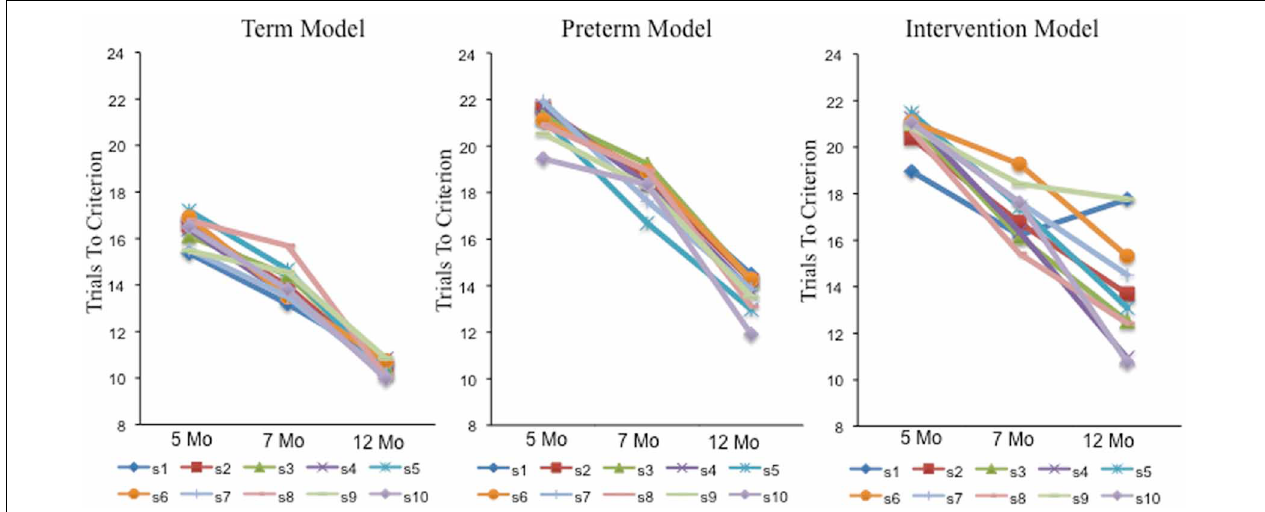
Table 1 | Predicting trials to criterion at 12 months.